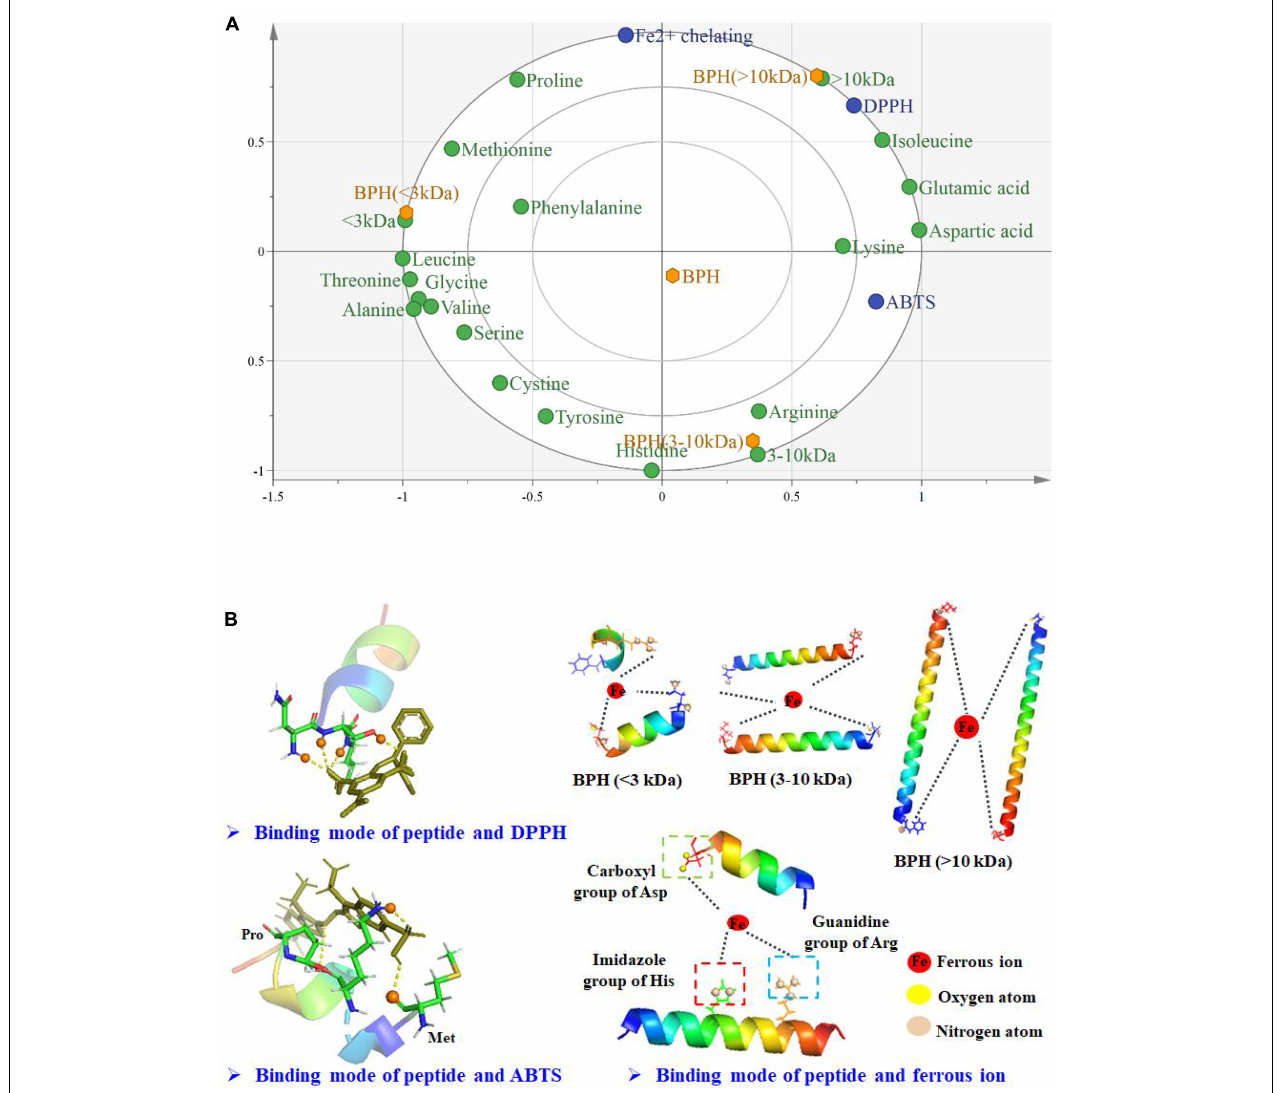
FIGURE 5 | Biplot for BPHs of the correlation of molecular weight, amino acids, and antioxidant properties (A) ; Simplified antioxidant model of fractionated hydrolysates (B)